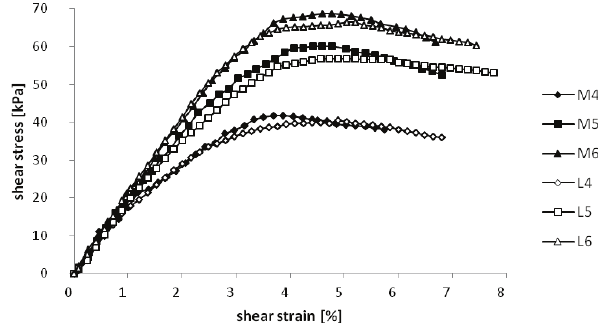
Fig. 4. Results of direct shear tests in medium and large box for sample preparation with 8% water